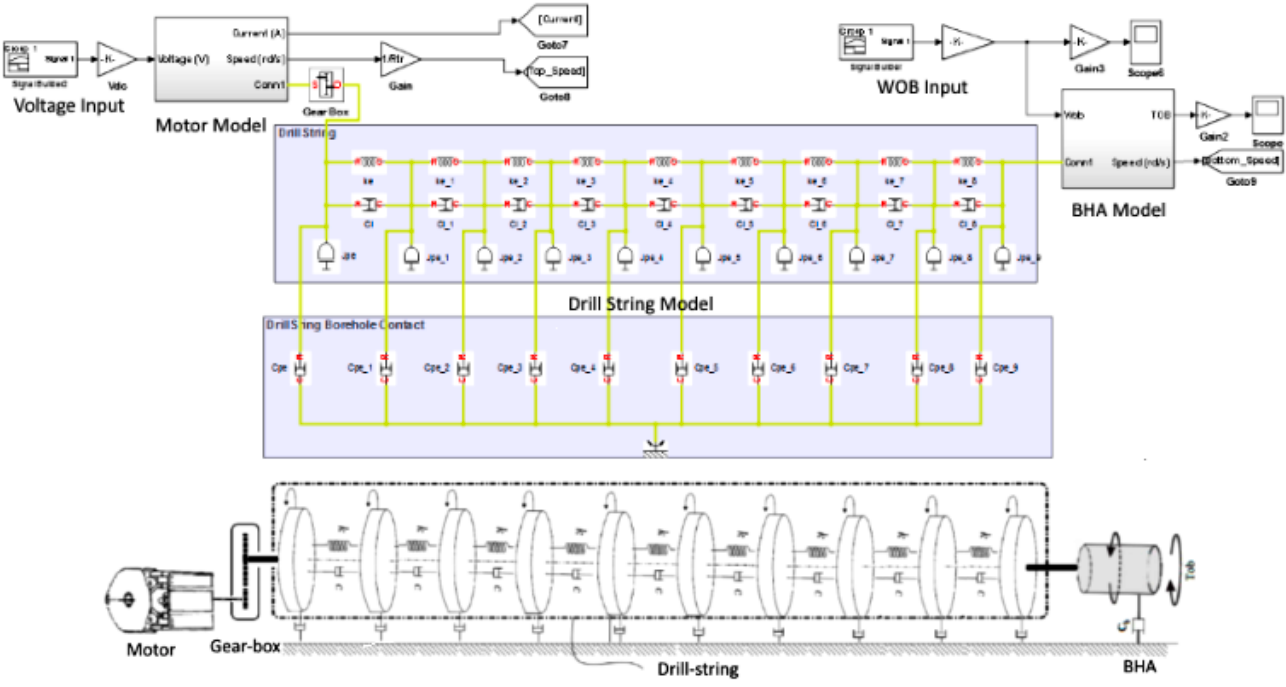
Figure 3. Rotary drilling system simulation model with ten degrees of freedom.